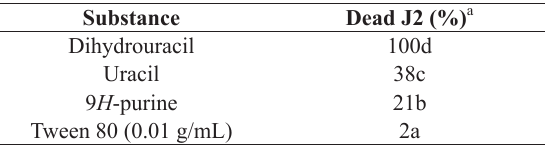
Effect of isolated bacterial metabolites at 500 µg/mL on Meloidogyne exigua second-stage juveniles (J2) .